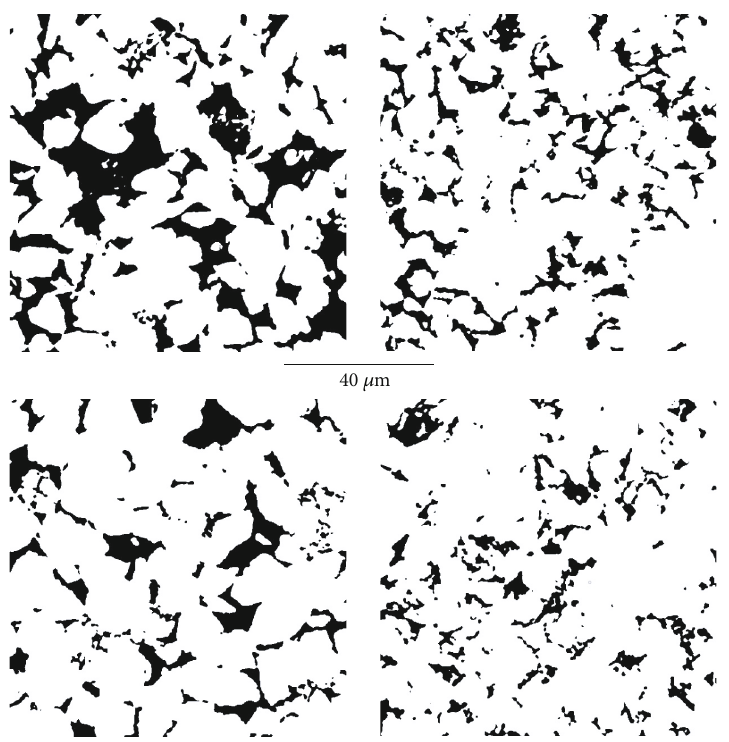
Figure 8: Binary section image of sandstones: (a) sandstone a; (b) sandstone b; (c) sandstone c; (d) sandstone